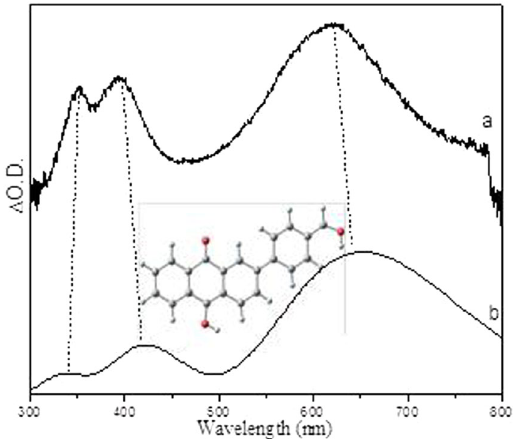
Figure 11. Comparison of ( a ) the experimental ns-TA spectrum of PPAQ obtained at 600 ns time delay of in pH 2 MeCN-H